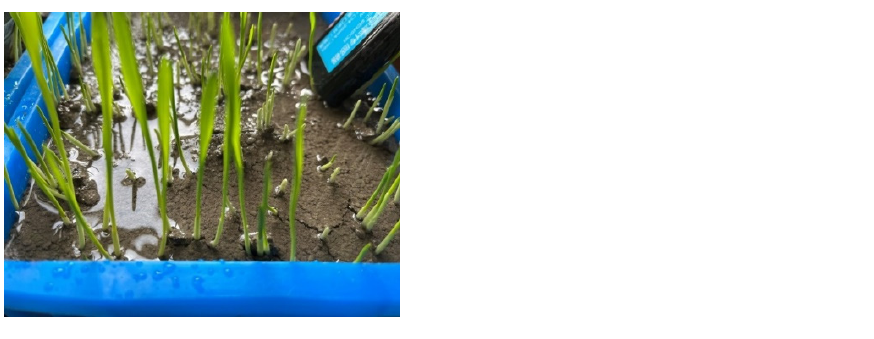
Figure 13. Formation of crusts on top and accumulation of water on the soil surface (1.00% XG–oat).